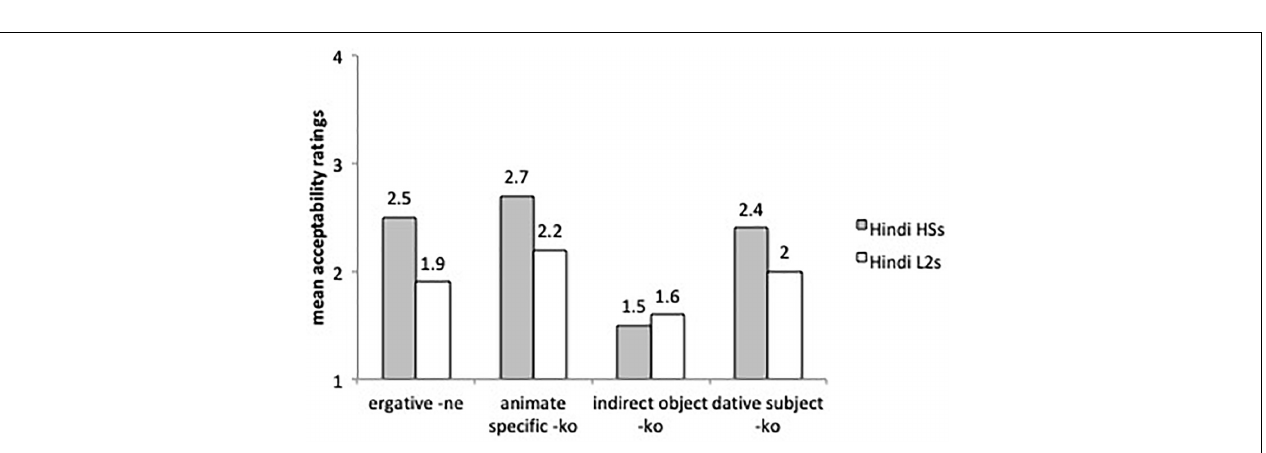
FIGURE 6 | Mean acceptability ratings on indirect objects and dative subjects with and without - ko .